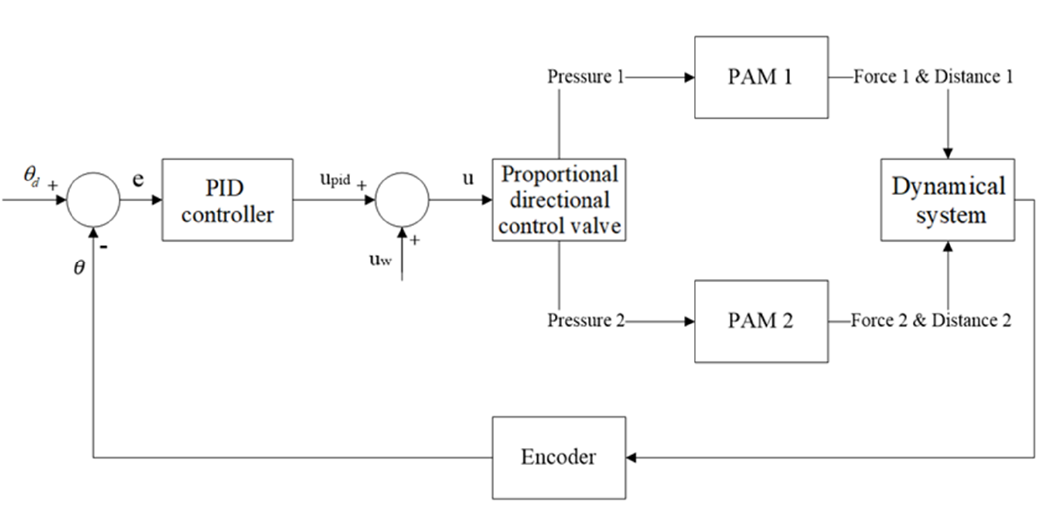
Figure 7. Flow chart of PID controller applied to proportional directional control valve.